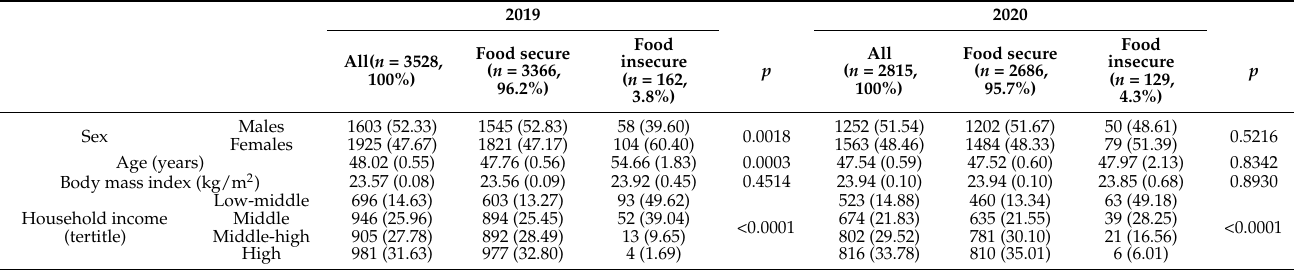
Table 1. Descriptive data of the study subjects by food security